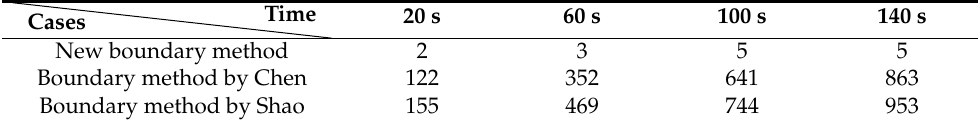
Table 3. Numbers of penetration particles in the SPH